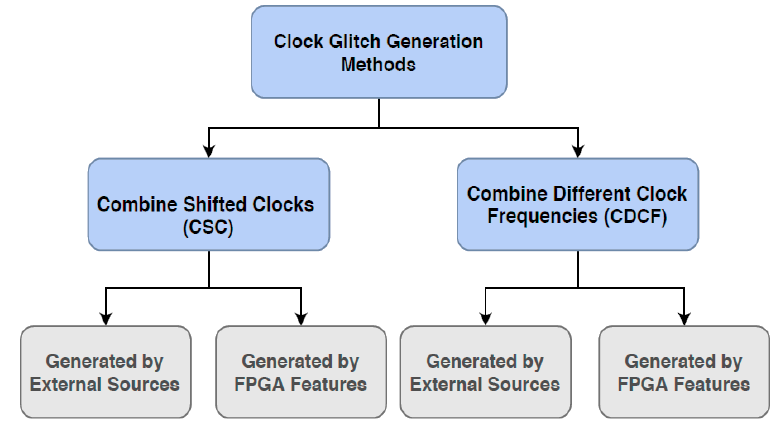
Figure 9. Different methods for generating clock glitch(es).